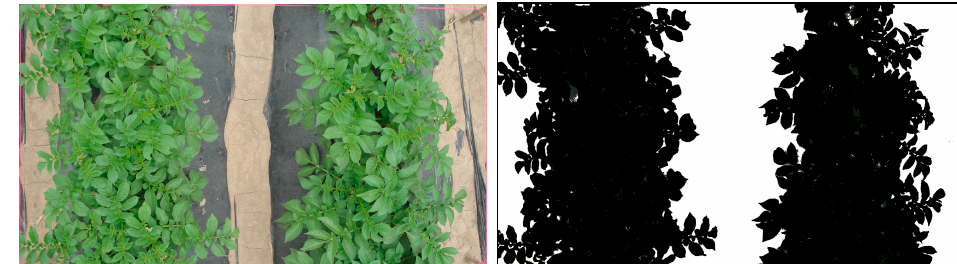
Figure 1. Example of potato canopy cover images taken at Wuwei, China on 2 June 2015 before and after processing for obtaining fractional canopy coverage.